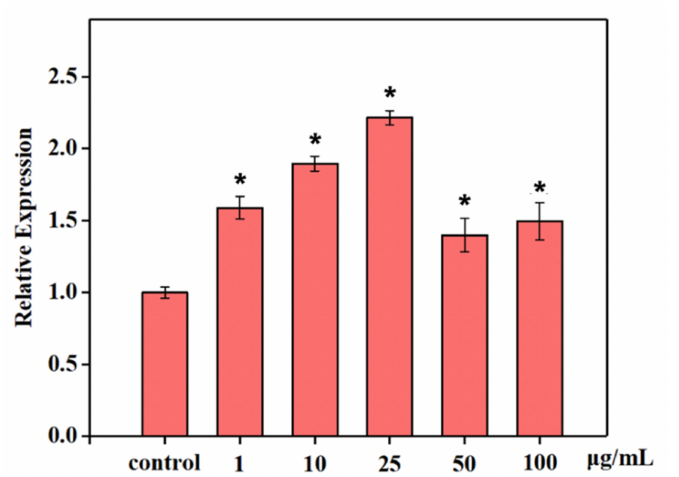
Figure 8. Content of cytokines Fas/Apo-1 in CD8 + T cells treated with varying concentrations of NTCII. (ShapiroWilk value > 0.05, using one-way ANOVA and Dunnette for post hoc tests.) An asterisk indicates that there is a significant difference compared with the control group (* p <